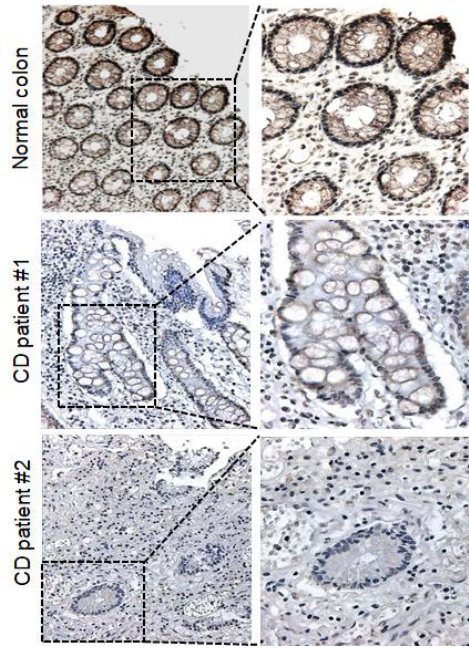
Figure 4. Protein expression levels of FHIT in CD tissue and normal colon tissue. Representative immunohistochemical analysis results showing FHIT expression in CD tissues and normal colon tissues. IHC analysis of FHIT was performed in both normal colon tissues ( n = 5) and patients with CD tissues ( n = 5). (Right images: 200×; left images: 400×).